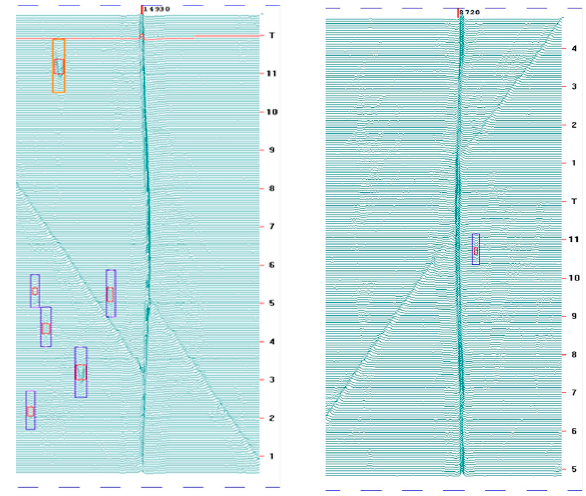
Figure 5. Type 3 MFL signals.